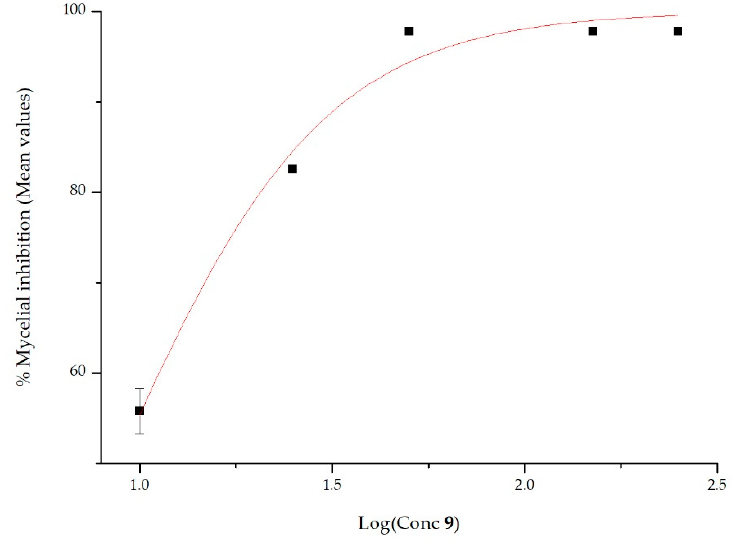
Figure 4. Inhibition data obtained for compound 9 fitted to a dose-response curve.